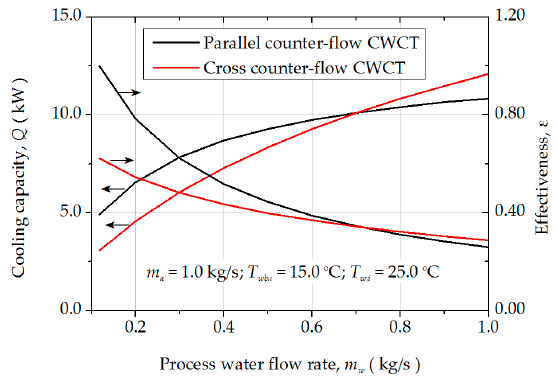
Figure 7. Cooling capacity and effectiveness versus process water flow rate (the arrows indicate the variable axes).